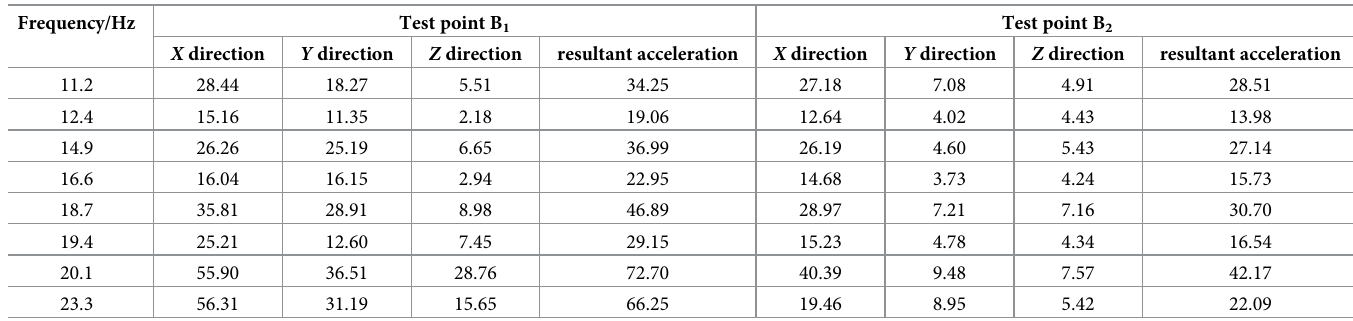
Table 3. The acceleration amplitude values of test points B 1 and B 2 (m/s 2